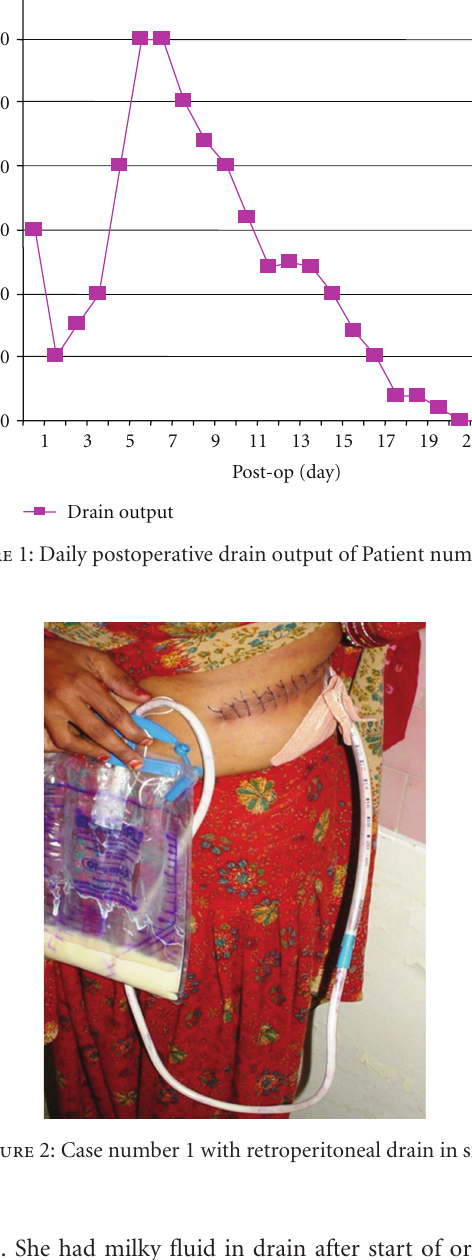
period. She had milky fluid in drain after start of oral diet (max output: (200/day)). This patient was also managed conservatively with dietary management. Leak gradually subsided spontaneously in 7 days (Figure 3).